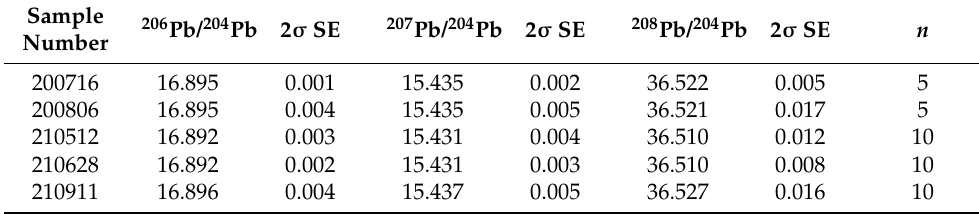
Table 4. TIMS results for NIST SRM